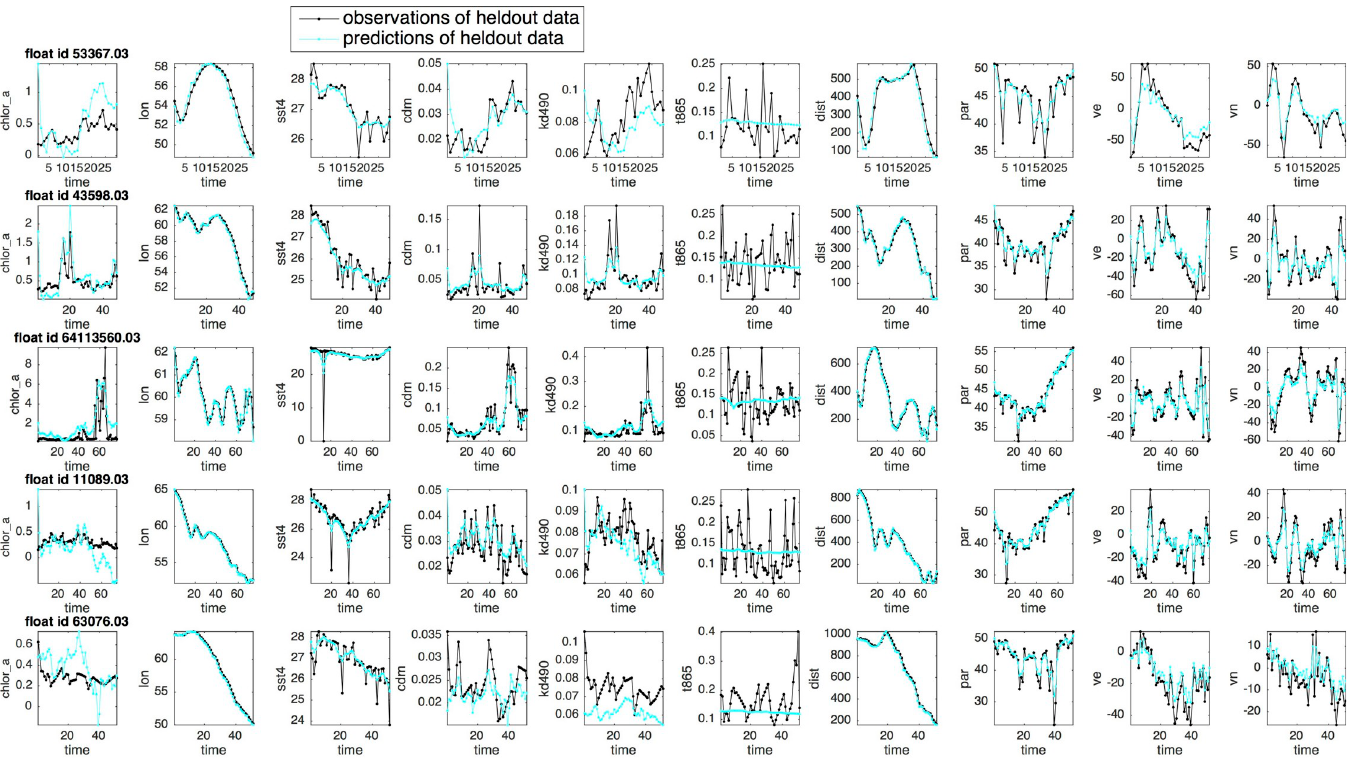
Fig 11. Predictions of the drifter profiles for the floats in the heldout testing dataset, using the expected conditional mean of the latent variables generated by one iteration of the forward-backward smoothing process of the Expectation-Maximization algorithm with the vLDS model parameter Y : ¼ A ; C ; G ; S ; μ optimized on the cross-validated dataset.